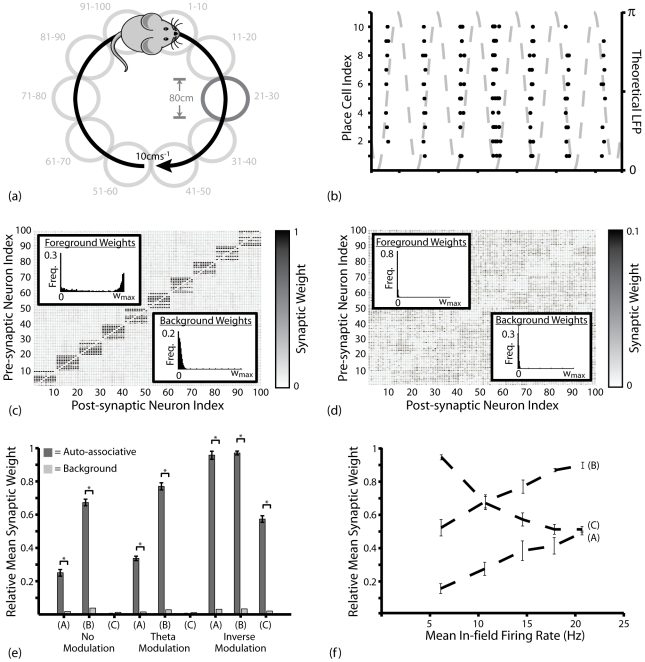
Theta Coded Auto-associative Learning in a Spiking Recurrent Neural Network.(a) Theoretical details of theta coded auto-associative learning simulations. 10 equidistant but non-overlapping place fields of 80cm diameter, offset by 80cm, form a circular route that is traversed repeatedly at a constant speed of 10cms−1. Each place field is encoded for by ten place cells. This form of input effectively corresponds to repeated presentations of ten binary and orthogonal activity patterns. (b) Typical spike raster in place cells encoding for a single place field. For illustrative purposes, this figure was generated with much smaller place fields (10cm diameter) such that typical activity at each phase of theta can be seen more clearly. (c) Typical synaptic weight matrix following learning with the BCM type STDP rules, illustrating how connections between neurons that encode for the same place field are selectively and significantly potentiated. Data shown for triplet-based STDP with theta modulated plasticity. (d) Synaptic weight matrix following learning with the non-BCM type STDP rule and theta modulated plasticity. Under these conditions, synapses between place cells that encode for the same place field are depressed below the mean weight of other connections in the network. (e) The mean weight of synapses connecting each place cell to those that encode for the same place field (dark grey) and different place fields (light grey) following ten traversals of the theoretical route, averaged over 50 separate simulations, for the pair- and triplet- based BCM type STDP rules (A and B respectively) and the non-BCM type STDP rule (C). (f) The relative mean asymptotic weight of auto-associative connections averaged over 50 separate simulations, illustrating that the relative strength of auto-associative connections is positively correlated with mean in-field firing rate for (A) the pair based BCM type STDP rule (with theta modulated plasticity); and (B) the triplet based BCM type STDP rule (with theta modulated plasticity); but negatively correlated with mean in-field firing rate for (C) the pair based non-BCM type STDP rule (with inversely modulated plasticity).